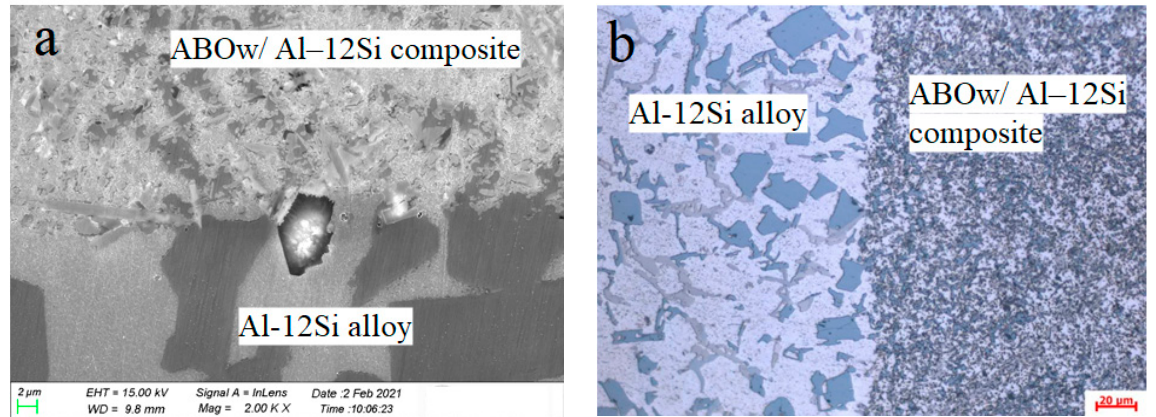
Figure 2. The ( a ) SEM fractograph with a 2000 magnification; and ( b ) optical micrograph with a 500 magnification of the composite bonding zone between the ABOw/Al–12Si composite and the Al–12Si alloy.